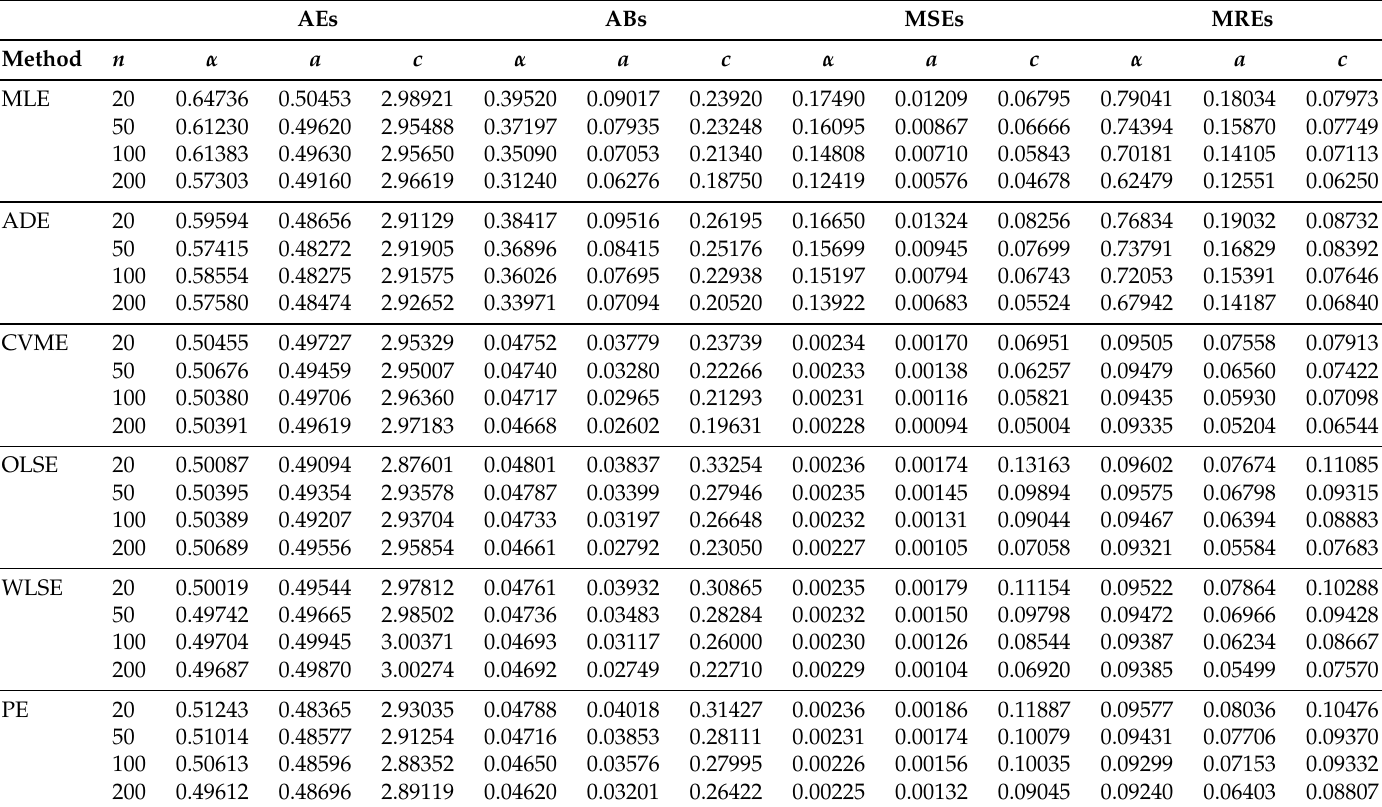
Table A7. The AEs, ABs, MSEs, and MREs for ( α = 0.5, a = 0.5, c = 3 )